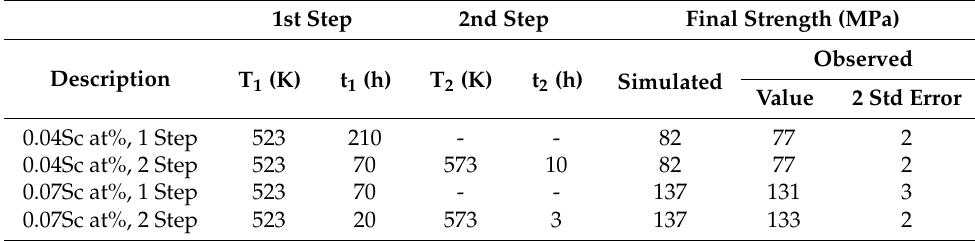
Figure 10. Graphs comparing the observed strengthening effects (via Vickers microhardness tests) and the corresponding model-predicted Orowan strengthening effects in several long heat treatments (Table 4). Error bars represent +/ − 2 standard error. Table 4. Long t 1 heat treatments and simulations.